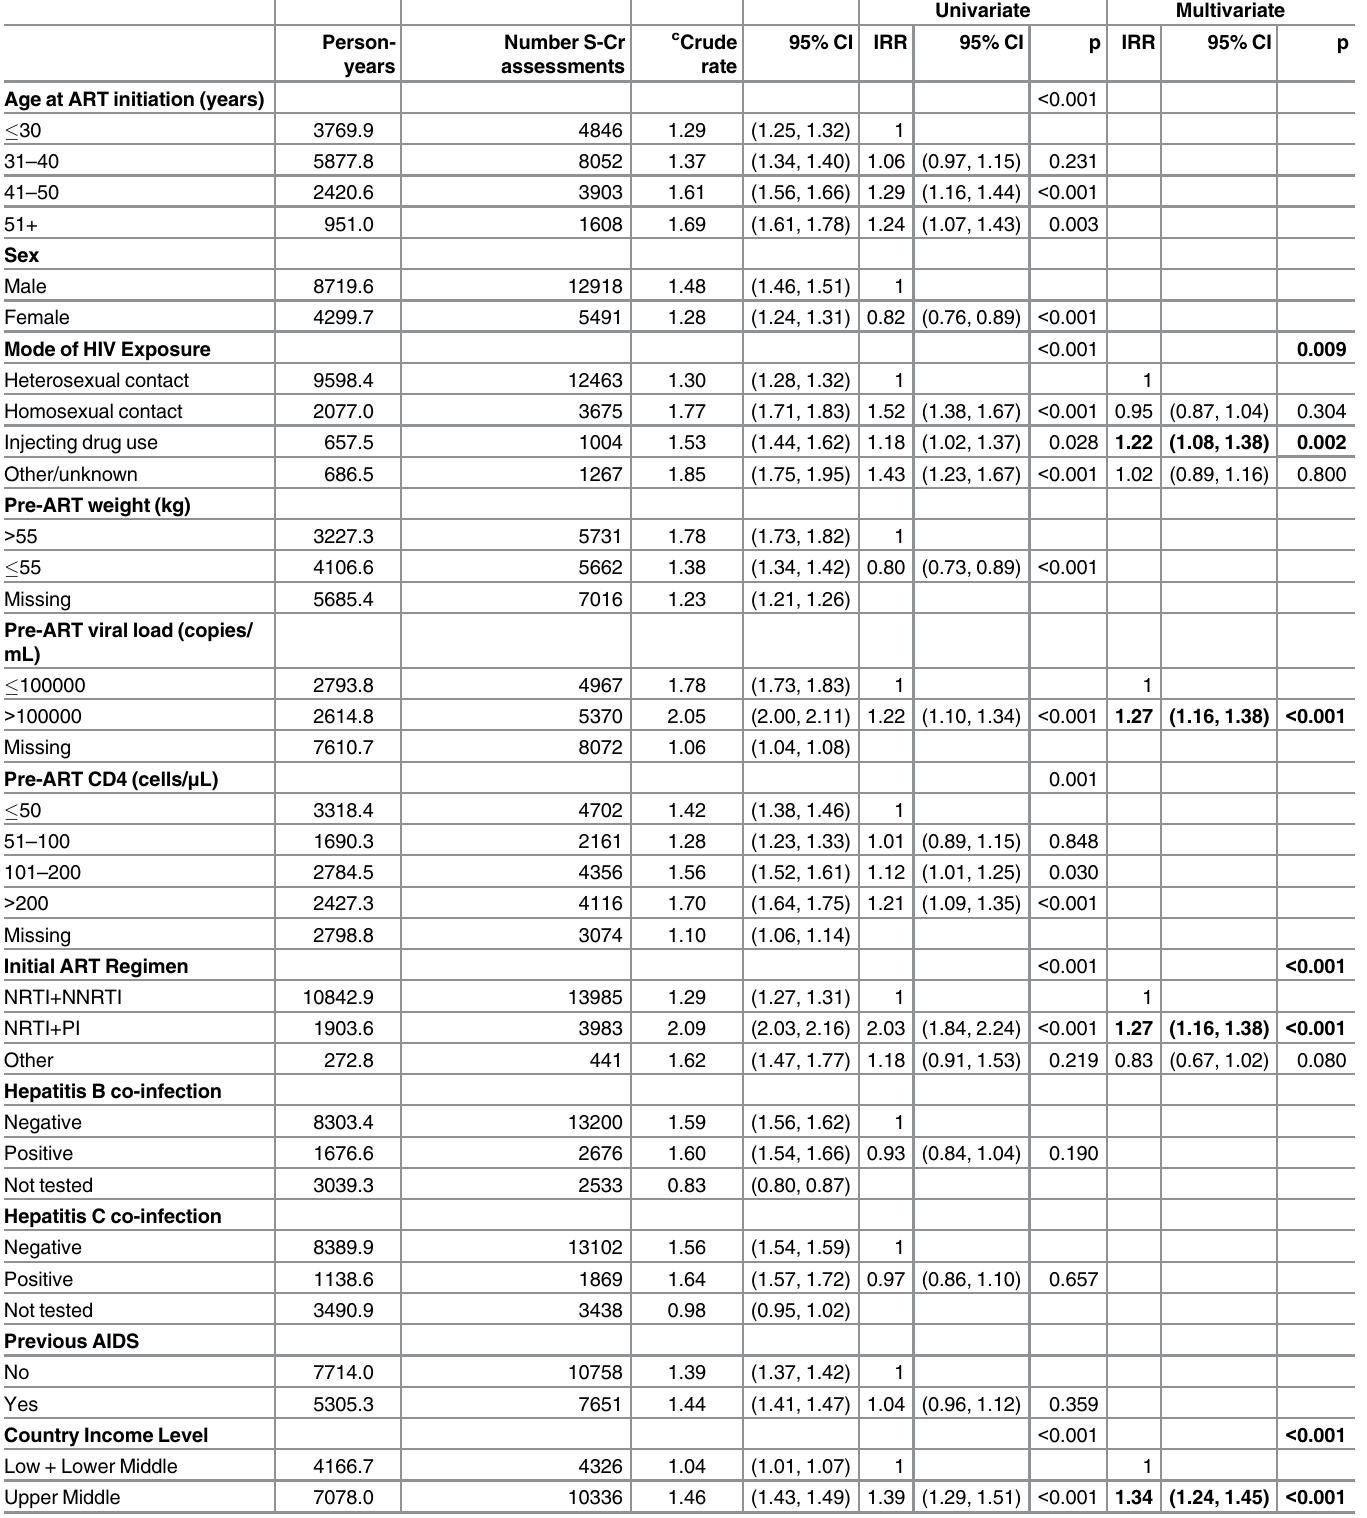
Table 2. Factors associated with rates of serum creatinine monitoring after ART